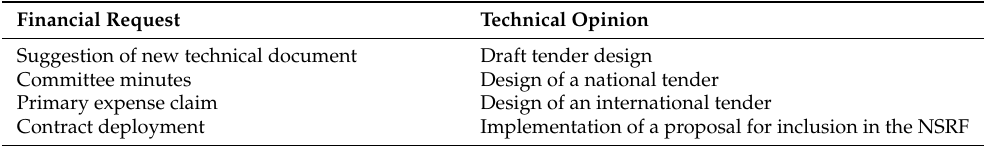
Table 1. Public body